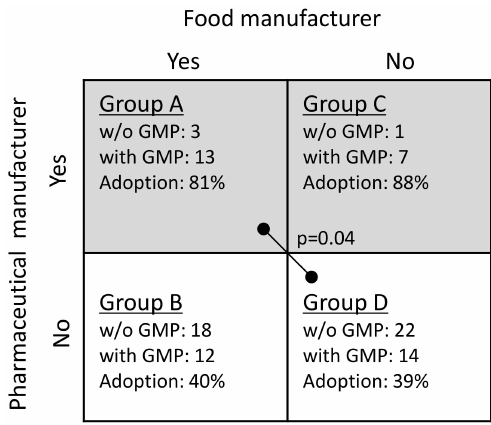
Figure 4. Summary of adoption rates of GMP for dietary supplements for possession of license(s) for manufacturing food and / or pharmaceutical